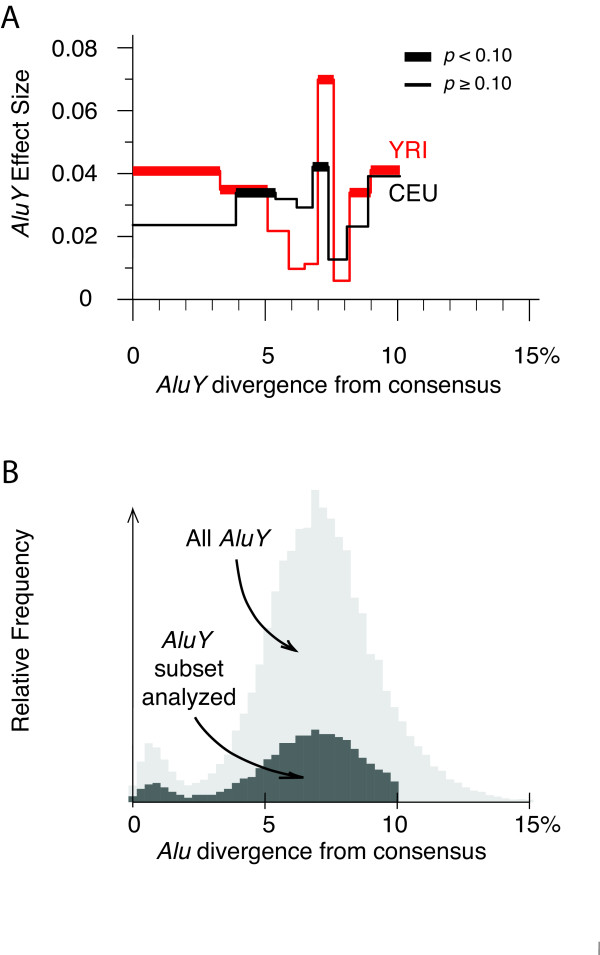
Size and significance of the effect of AluY insertions on the local recombination rate. (A) The effect of AluY insertions (linear regression coefficient for the AluY variable) is plotted against the percent divergence of AluY elements (binned into non-overlapping groups of approximately uniform number, i.e., 600-800 elements; divergences taken from RepeatMasker). The red and black lines correspond to results from the HapMap YRI and CEU data sets, respectively. (B) Histogram of AluY element frequencies vs. percent divergence from their respective subfamily consensus sequences. Only elements between 250 and 350 bp long, with no more than 10% of their sequence deleted or composed of non-Alu insertions, were counted. The dark gray histogram shows the distribution of AluY elements that were chosen for regions analyzed in this work (magnified vertically by fivefold for visibility), while the light gray histogram includes all AluY elements. The horizontal axes in both panels are identically scaled and aligned.